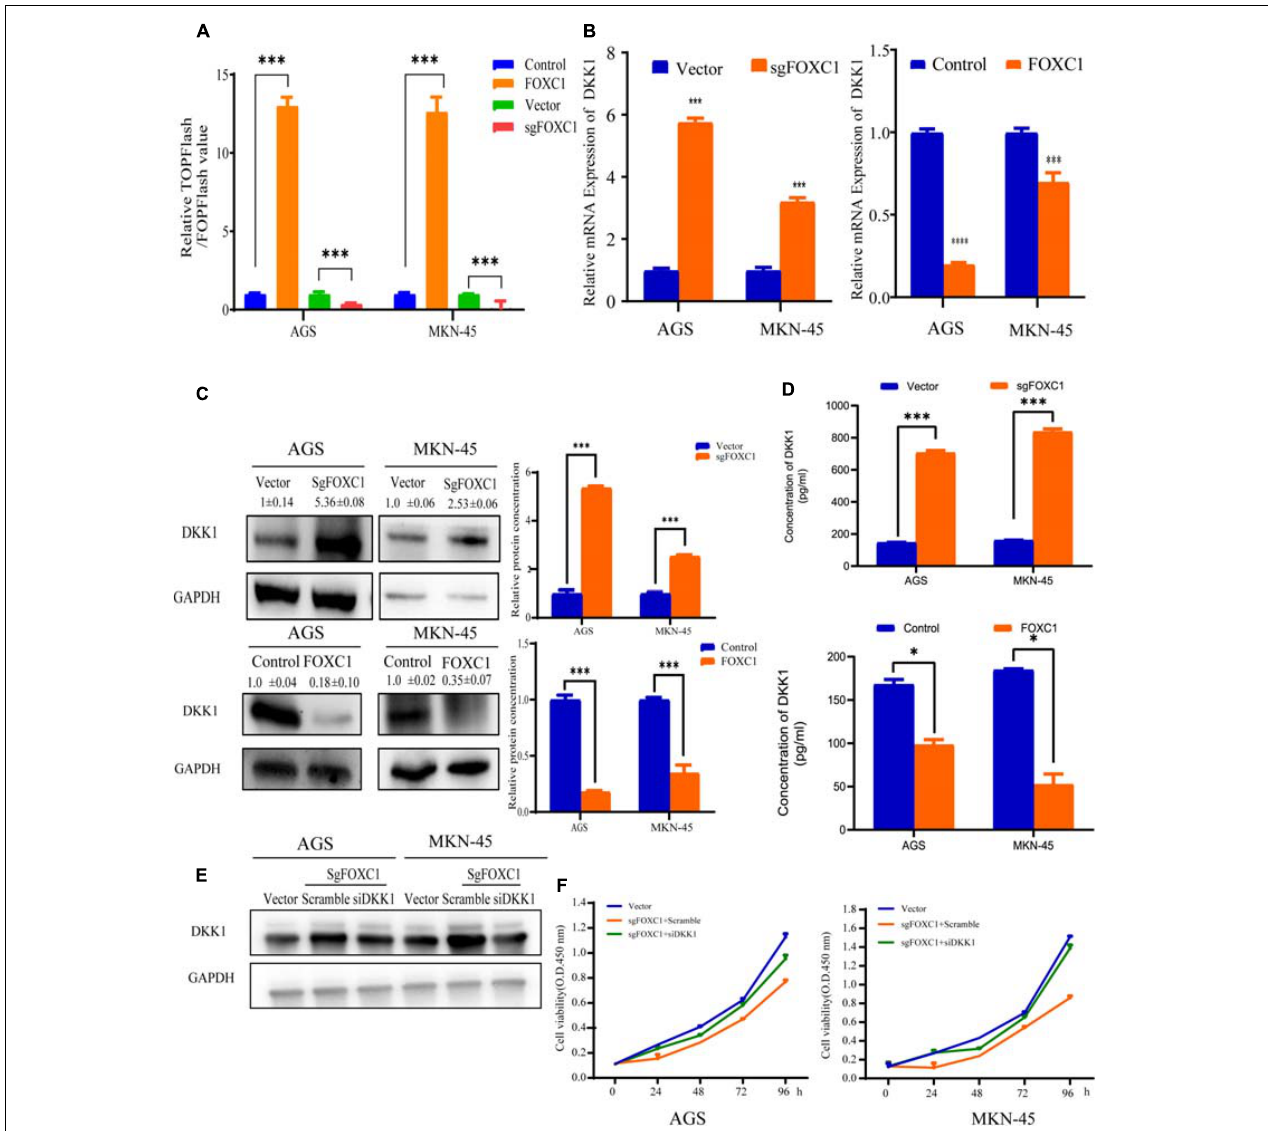
FIGURE 6 | FOXC1 promotes GC cell proliferation via downregulation of DKK1. (A) TopFlash/FopFlash assays were used to investigate activity of the Wnt signaling pathway in FOXC1 KO and FOXC1 overexpression AGS and MKN-45 cells. The results demonstrated that FOXC1 KO decreased activity of the Wnt signaling pathway and forced FOXC1 expression could increase activity of the Wnt signaling pathway. (B–D) qPCR (B) , western blot (C) and ELISA (D) assays in FOXC1 knockout GC cells were used to analyze the mRNA and protein levels of DKK1. (E) Western blot assay was applied to confirmed the knockdown efficiency of DKK1 in FOXC1 KO AGS and MKN-45 cells. (F) DKK1 knockdown could restore FOXC1 KO-induced suppression of AGS and MKN-45 cell proliferation. All CCK-8 assays were performed three times and showed the same trend and representative results were shown inpanel (F) . * P < 0.05, *** P <